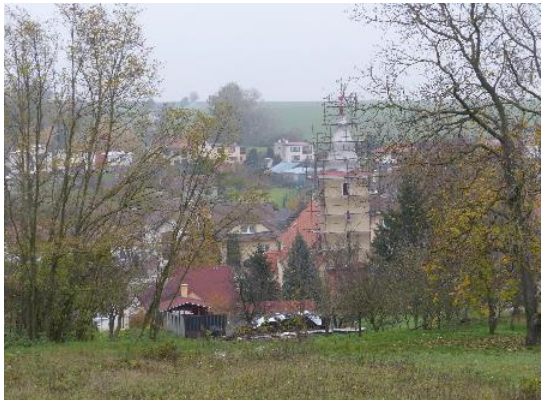
Figure 3. Dolný Lopašov community (Moyzeová, 2020) .